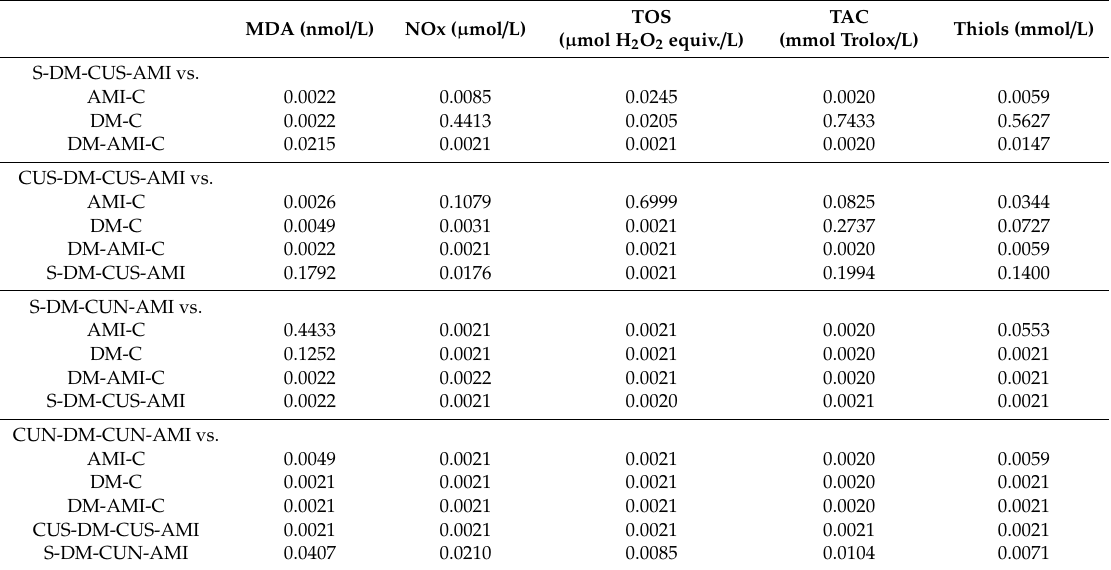
Table 6. P -values for comparisons between the study groups for oxidative stress parameters.